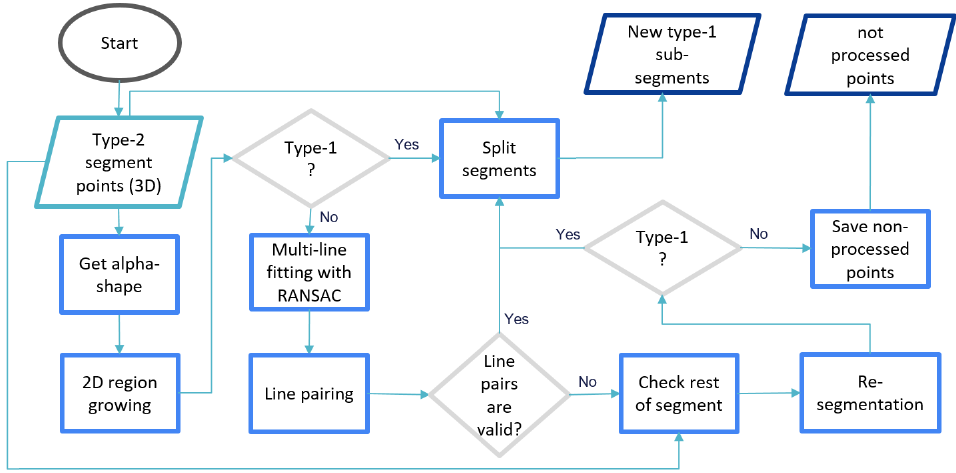
Figure 8. Automation flowchart of linear (straight) part splitting for type-2